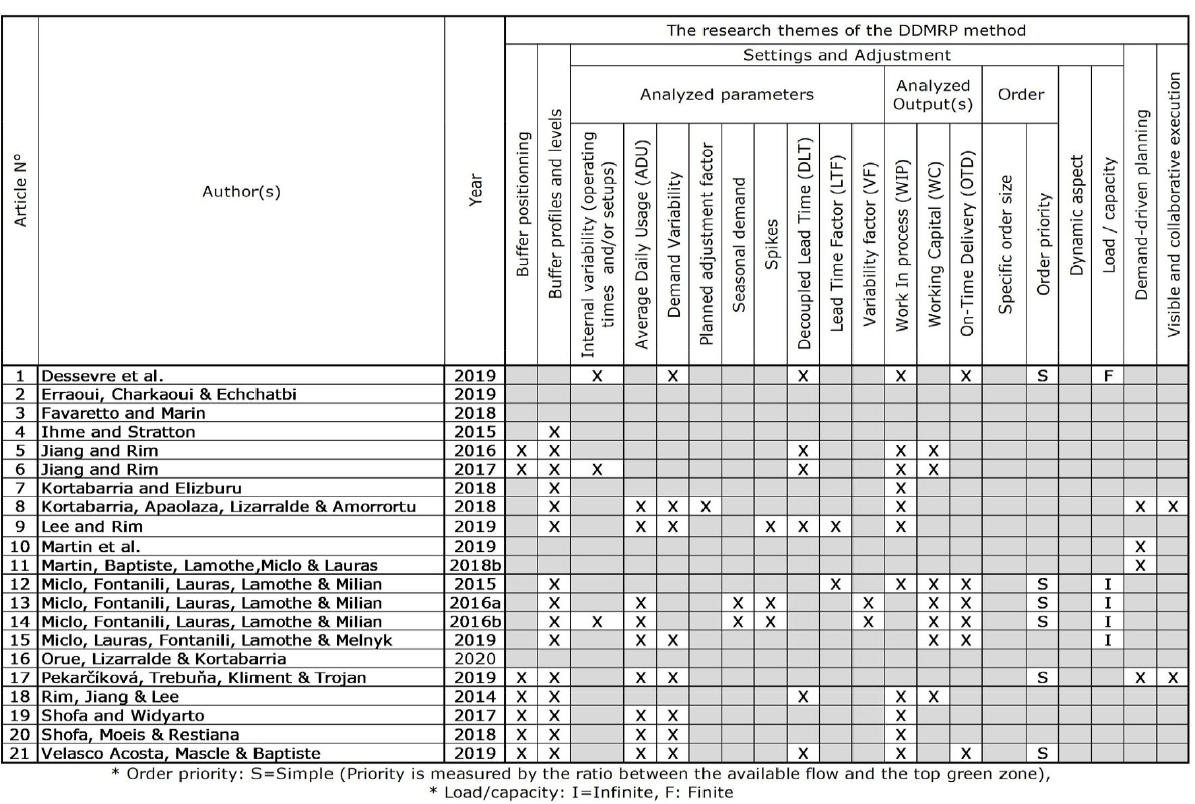
Table 3. DDMRP techniques and parameters